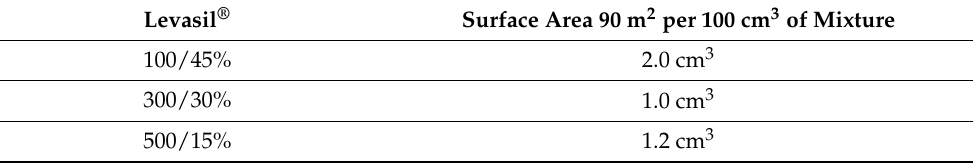
Table 1. The Levasil ® volumes used for chitosan/Levasil ® mixture